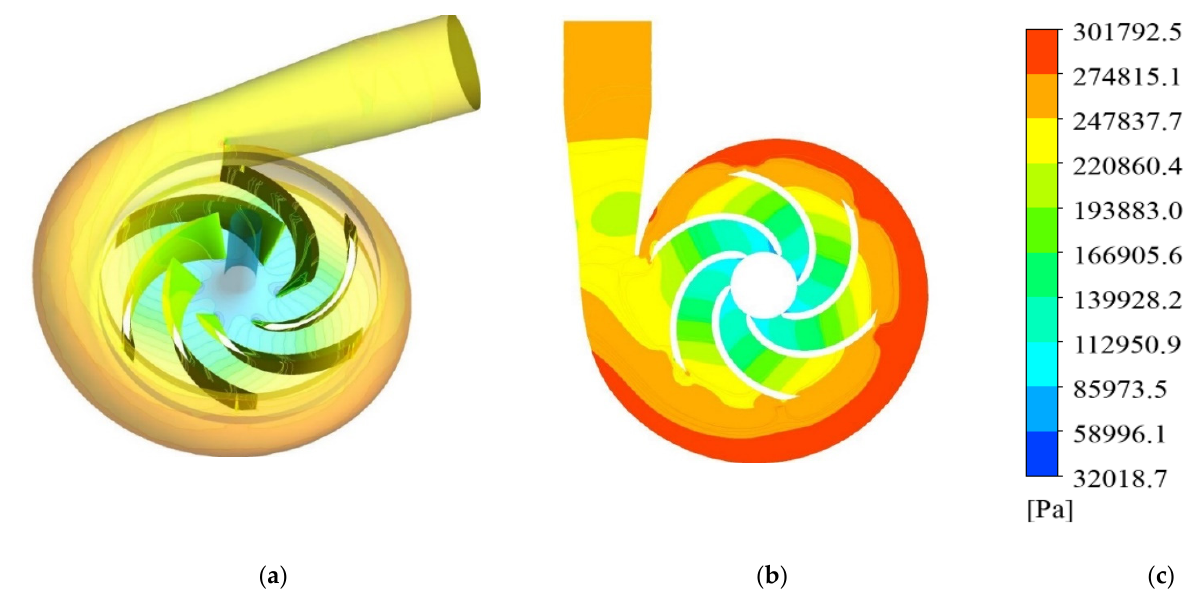
Figure 6. ( a ) Pressure contours on the pump casing, Blades, and hub, ( b ) Pressure contours on a cut plane passing through a 50% span of the blades while the volume concentration of the particles is 5%, ( c ) legend.